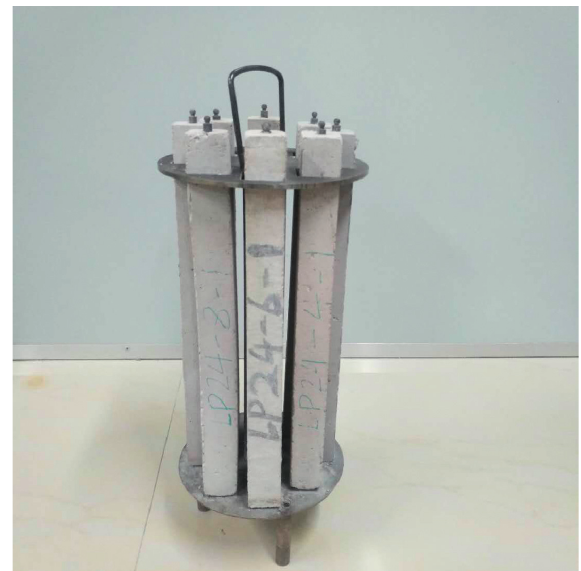
Figure 3: Autoclaved